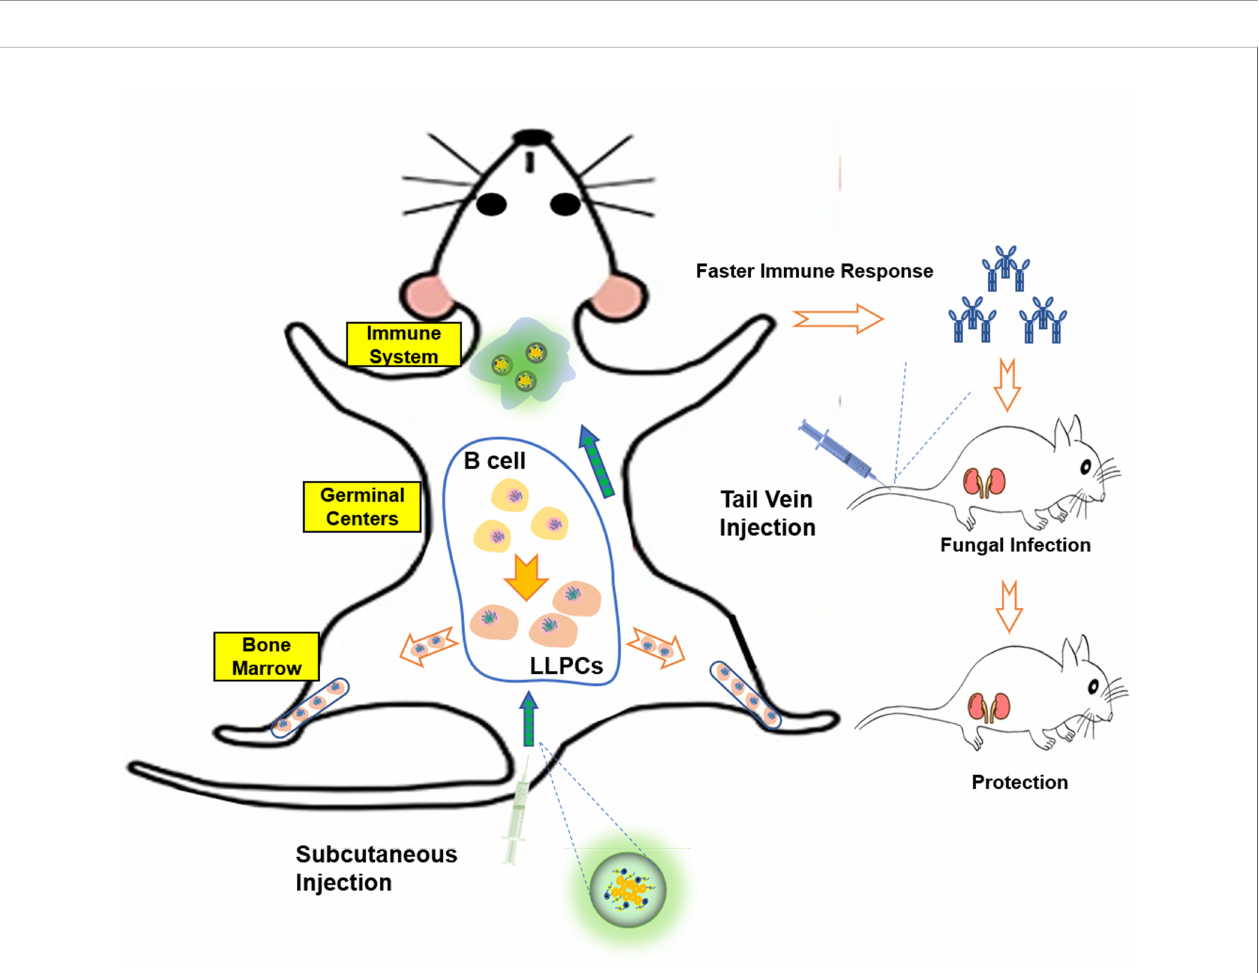
FIGURE 9 | Schematic representation of Hsp90-based antigen delivery system and its role in eliciting cellular immunity response. Nanovaccine in mice caused immune response, so that the body quickly produces antibodies and plays a protective role. At the same time, the vaccine can promote the differentiation of B cells into LLPCs, so that the body has long-time protective